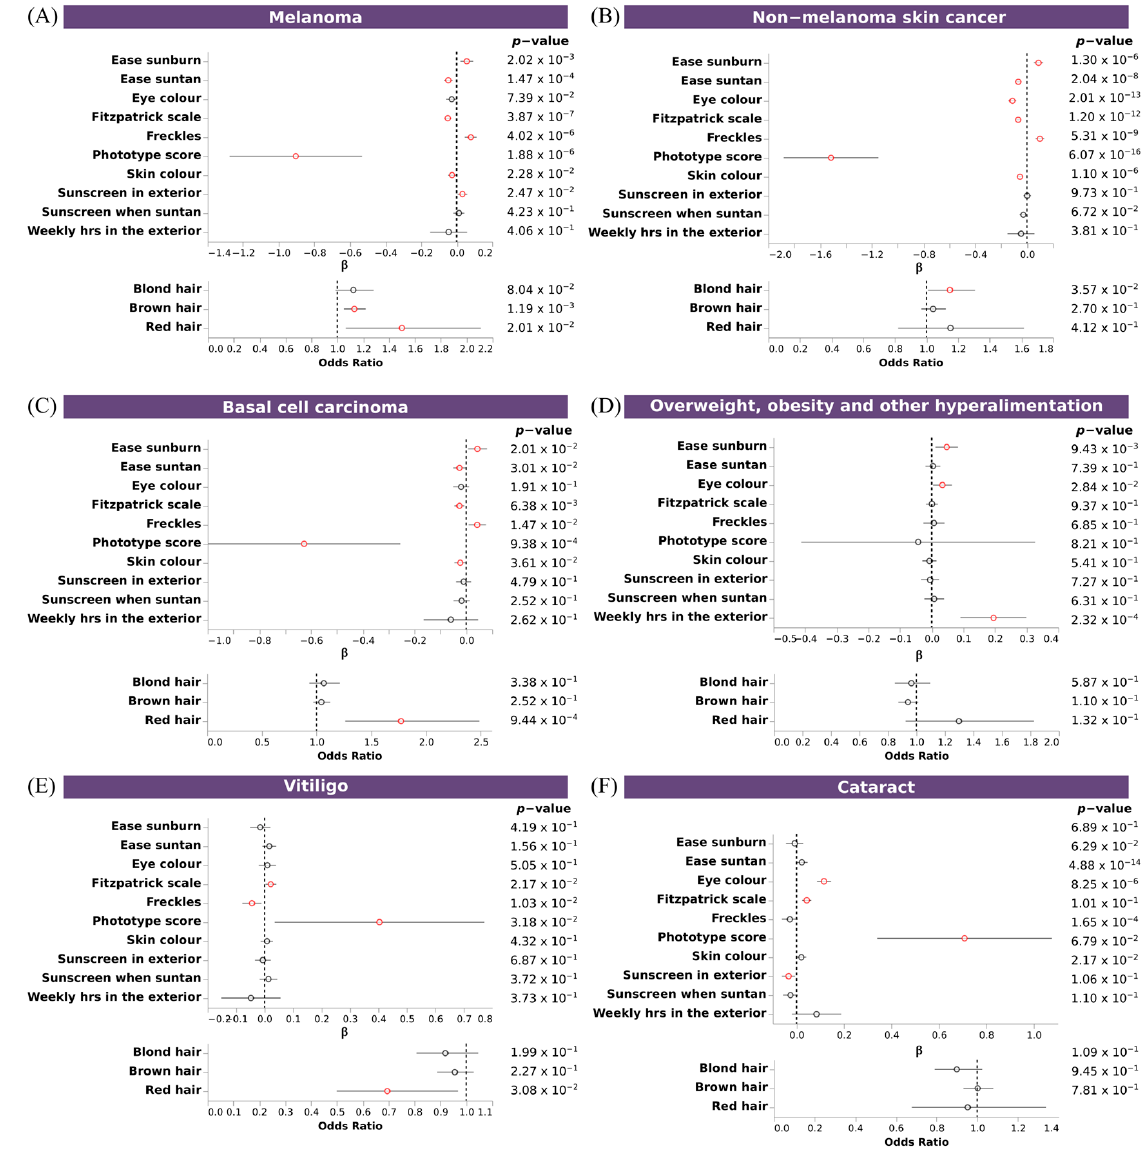
Figure 6. Association of PRS of skin and sense organs diseases with pigmentary traits. Forest plot depicting the effect size of significant PRS ( A – F ). Upper plots, depicting the β value and the 95% CI of discrete and continuous variables, and bottom plots, depicting the odds ratio and the 95% CI of binary variables, for each regression between PRS and pigmentary traits. X axis indicates the effect size for each pigmentary trait (Y axis). Additional information about p -value is shown. Associations reaching the nominal significance threshold are highlighted in red.